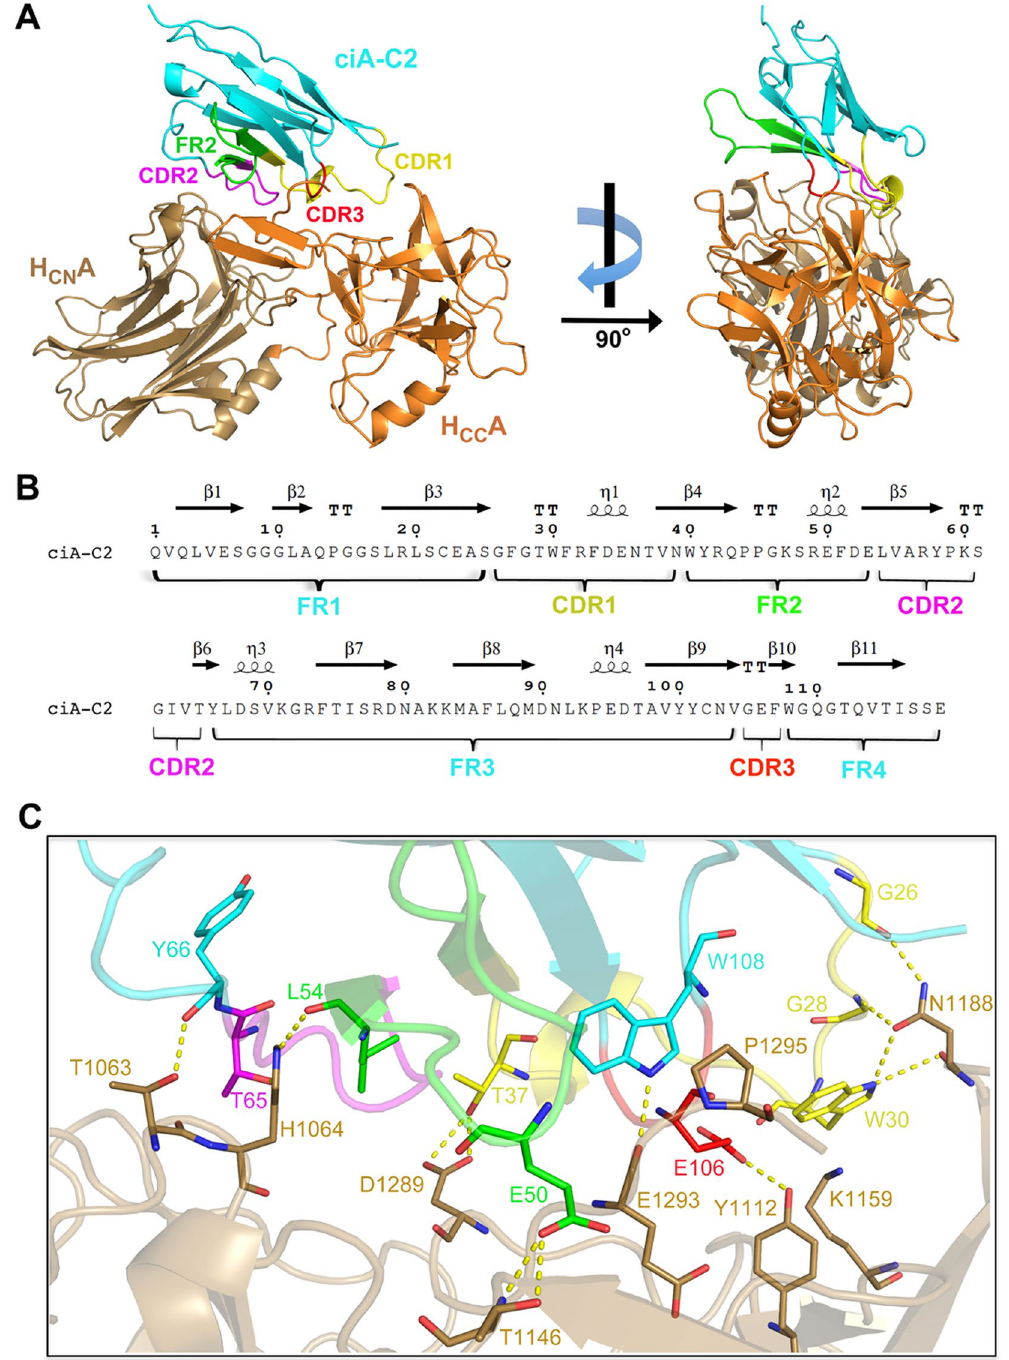
Figure 3. Structure of the H C A1-ciA-C2 complex. ( A ) H C A1 is colored as in Fig. 1A. ciA-C2 is colored in cyan while its CDR1, CDR2, CDR3 and FR2 regions are colored in yellow, magenta, red and green, respectively. ( B ) Amino acid sequence of ciA-C2 with secondary structures shown on the top (ENDscript 2.0) 57 , and the Kabat complementarity determining regions (CDRs) and framework regions (FRs) indicated on the bottom. ( C ) A close-up view of the interface between ciA-C2 and H C A1 using the same color scheme as panel A. Interacting residues are shown in sticks. Yellow dashed lines indicate hydrogen